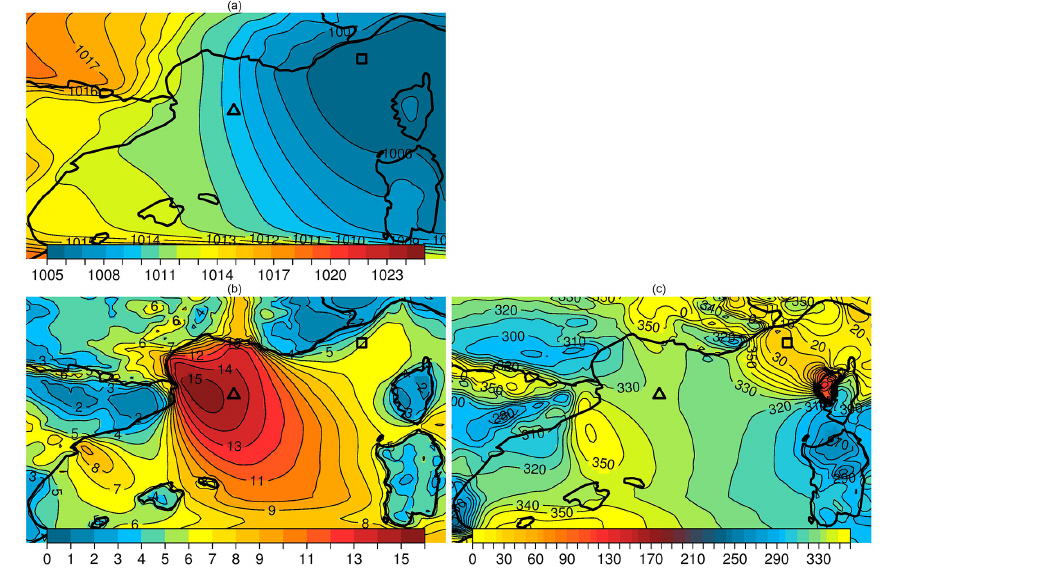
Figure 3. Mean sea level pressure [hPa] (a) , mean 10m wind speed [ms − 1 ] (b) and mean 10m wind direction [ ◦ ] (c) during Mistral events in the reference simulation ( α = 0 . 0123) in the Gulf of Lion area. Locations of Lion (triangle) and Azur (square)